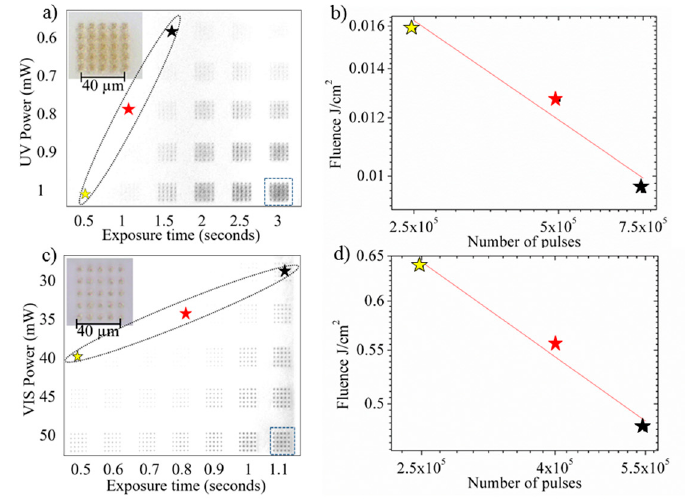
Figure 2. Identification of threshold irradiation parameters for ps laser irradiation of Foturan glass. ( a , b ) Optical images of the exposure map written on glass surface using 355 nm ps laser pulses ( a ) and corresponding critical fluence determination ( b ); ( c , d ) Optical images of the exposure map written on glass surface using 532 nm ps laser pulses ( c ) and corresponding critical fluence determination ( d ). The inset images represent detailed views of areas marked with square dots.